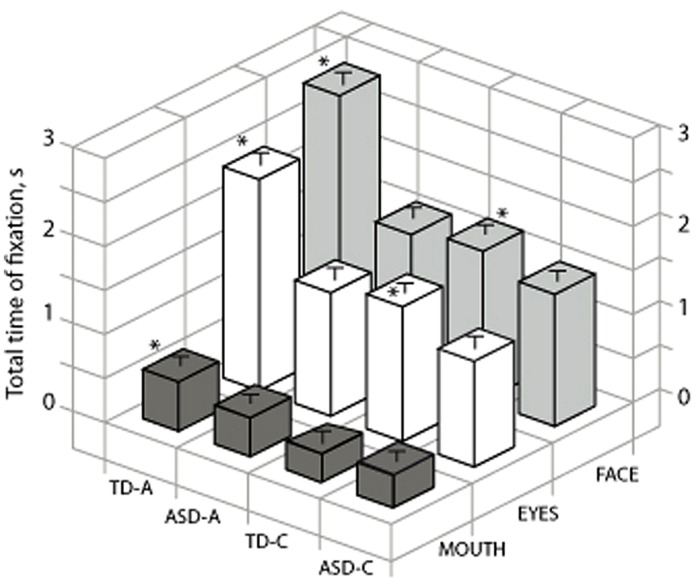
Comparison for the four groups of total time spent on the eyes and mouth. TD-A, typical adult; TD-C, typically developing children; ADL/ASD, adults with autism spectrum disorders; ASD-C, children with ASD. Stars on the graph indicate significance between groups for each ROI as for all four groups the time spent in each ROI was significantly different (see text). ∗ indicates a significant variation.